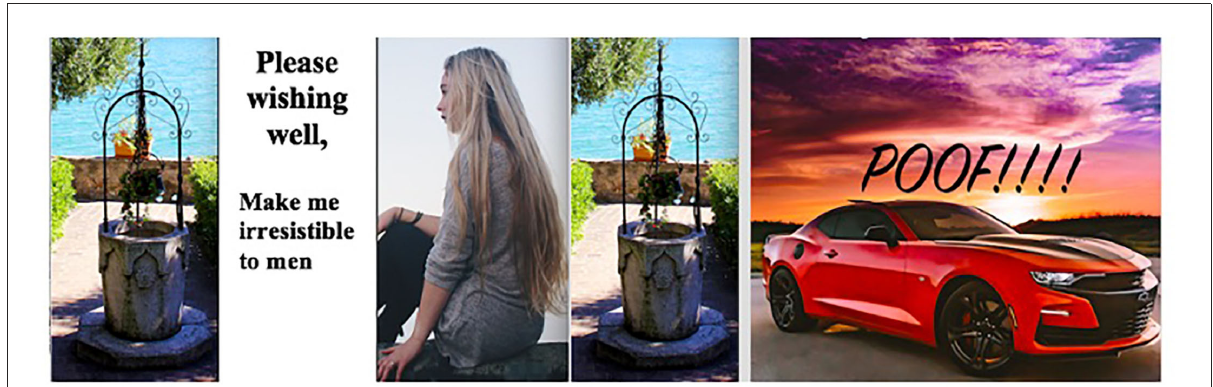
FIGURE3 Please wishing well… Photo credits for meme: Francesca Minto on unsplash: wishing well: https://unsplash.com/es/fotos/-H38UIFvodo; https:// unsplash.com/license. Zachary Staines on unsplash: woman sitting: https://unsplash.com/photos/JMKkm3leBKE; https://unsplash.com/license. Yuvaraj Singh on unsplash: car https://unsplash.com/photos/EqPF4QT60j4; https://unsplash.com/license.